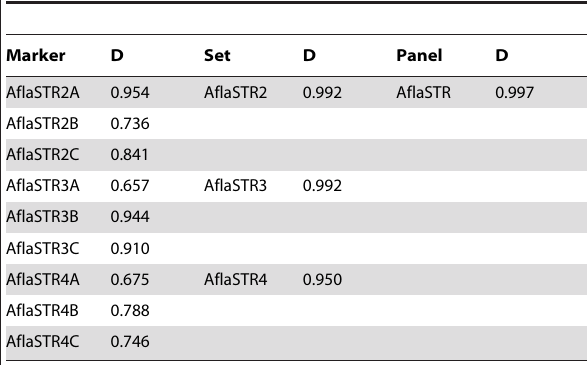
Table 2. Discriminatory power (D) of individual markers, sets of markers and the entire panel of